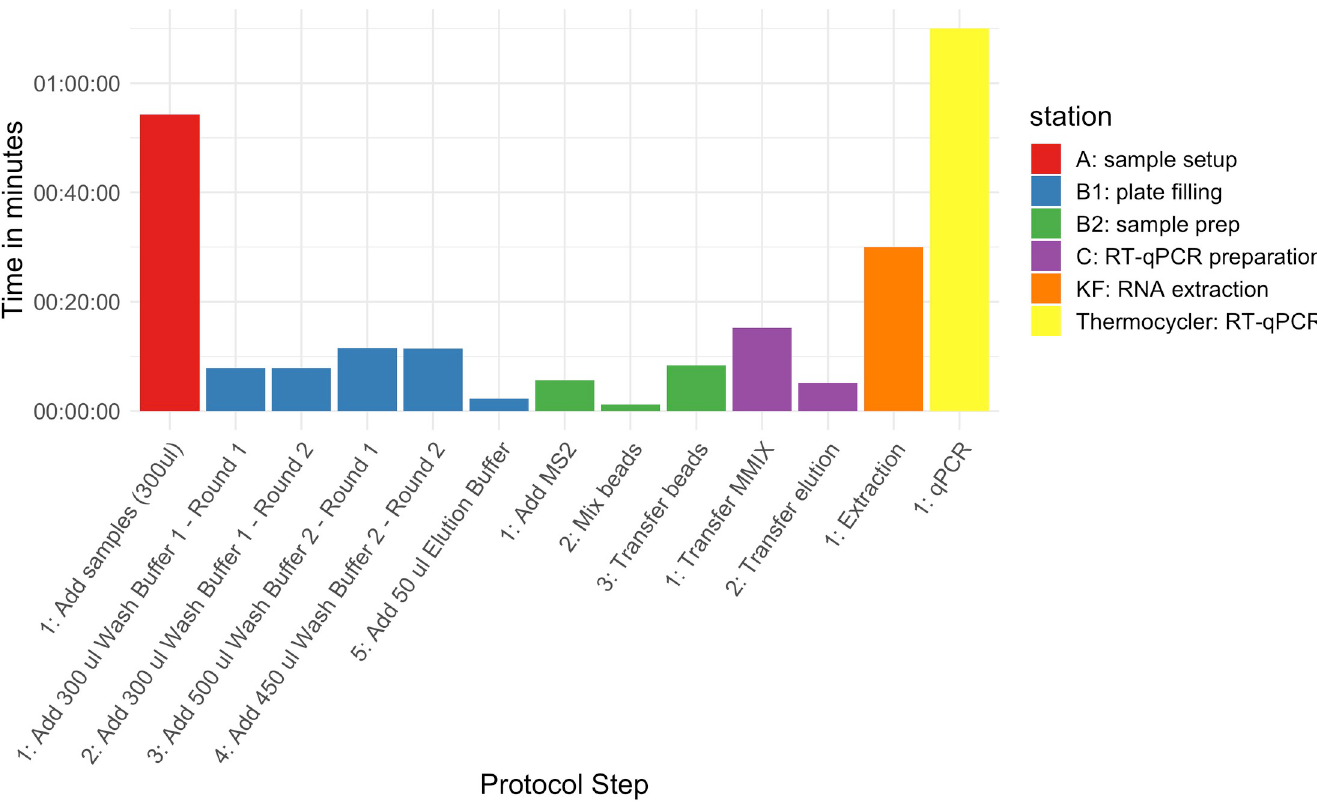
Fig 2. Run times in minutes for the different steps classified by station in the Kingfisher pathogen circuit using the MagMax ™ Pathogen RNA/DNA kit.